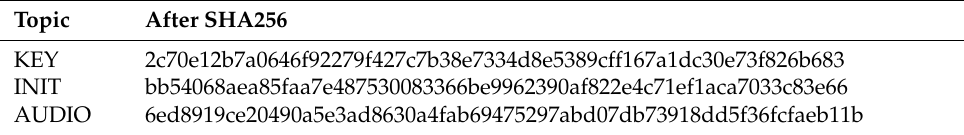
Table 1. Topics after SHA256 algorithm processing.